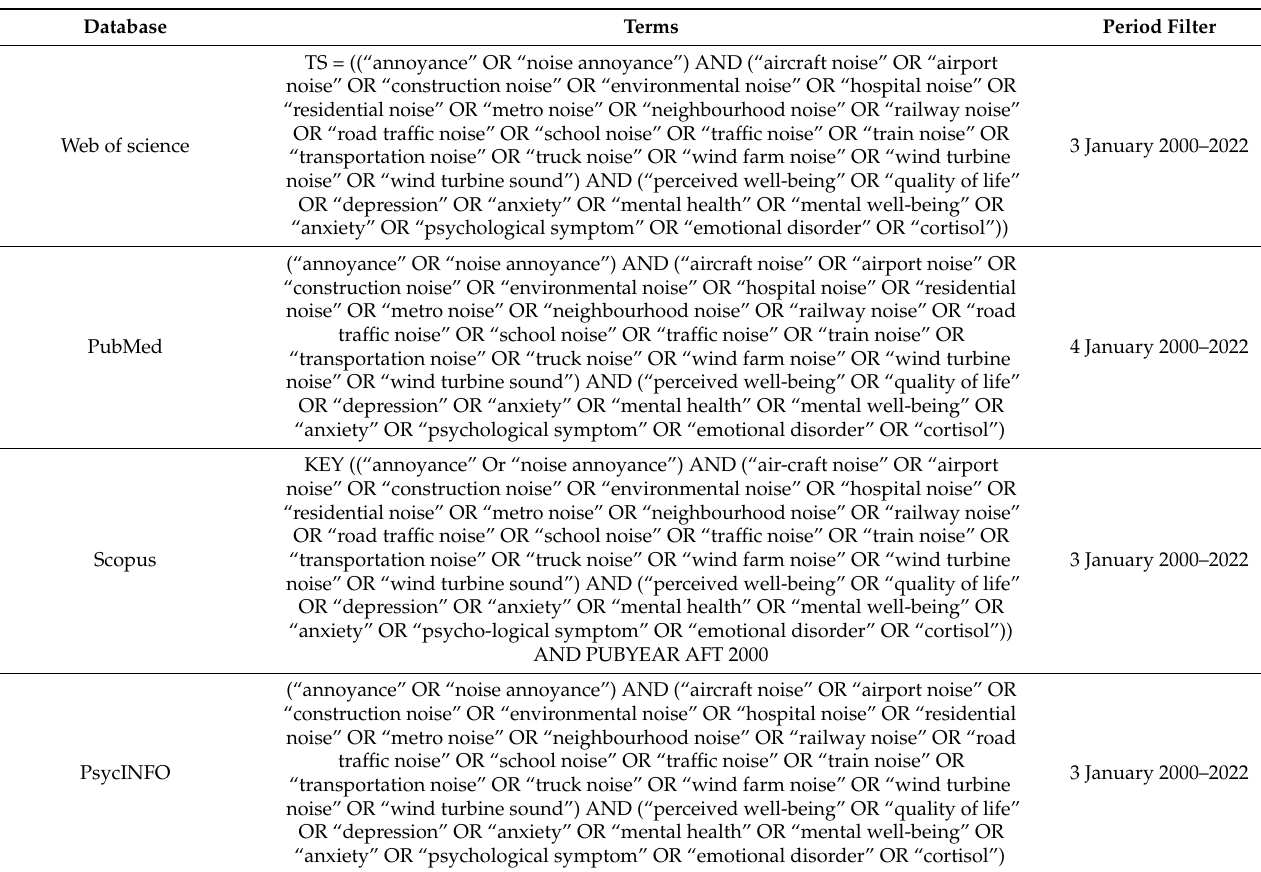
Table A2. Search terms used in Web of Science and PubMed database